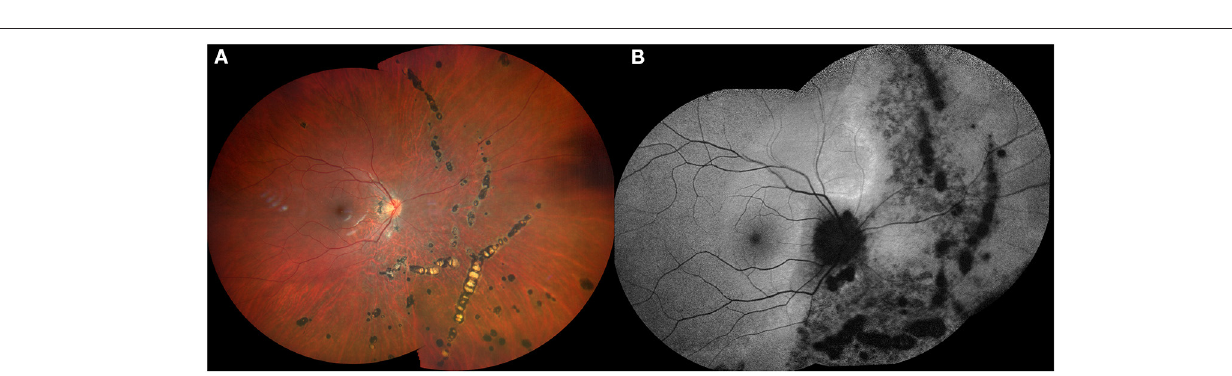
FIGURE 3 | Fundus color photograph (A) and fundus autofluorescence image (B) of a 26-year-old myopic female showing curvilinear streaks in the nasal midperipheral and peripheral retina of her right eye in association with multifocal